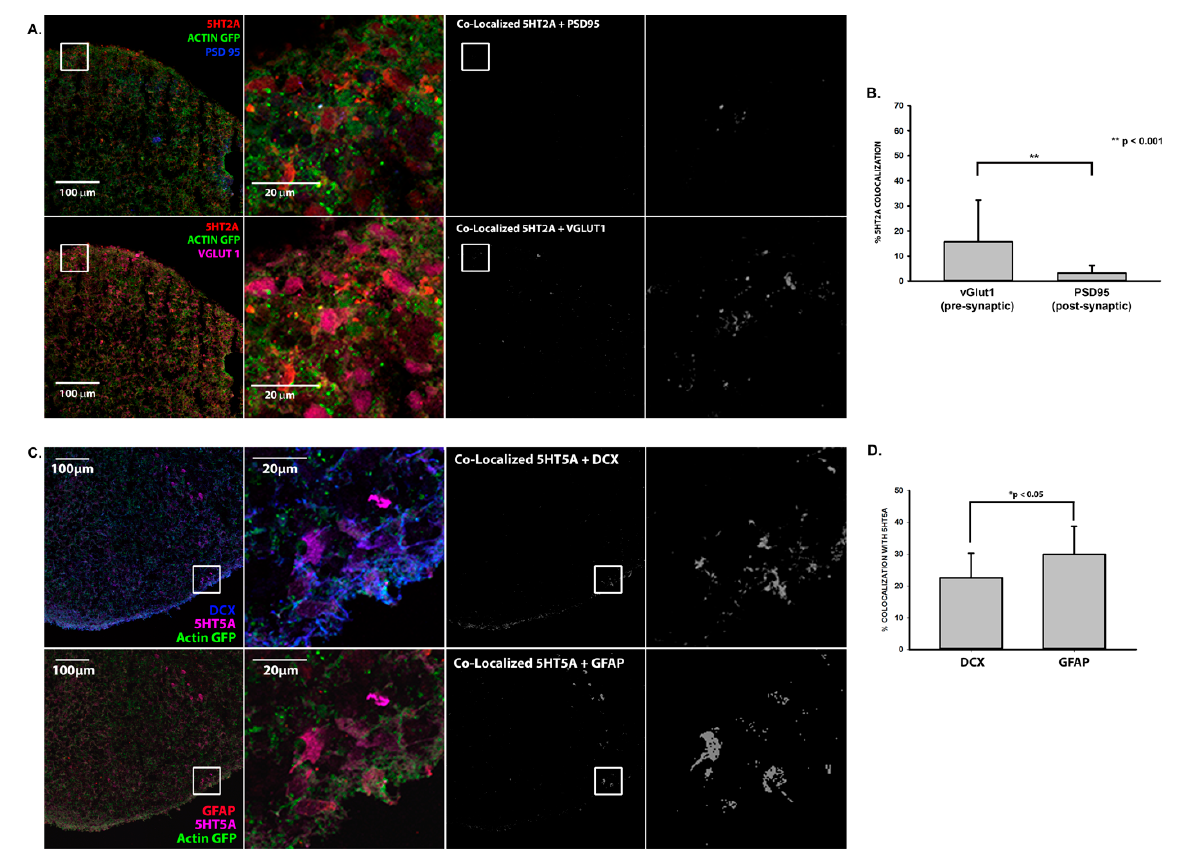
Figure 3. Expression of serotonin receptors in human cortical spheroids. ( A ) 3-month-old untreated cortical spheroids were immunostained for the serotonin receptor, 5-HT2A (red), and excitatory post- (PSD95, blue) and pre- (VGLUT1, magenta) synaptic markers and imaged with confocal microscopy together with endogenous β -actin-GFP. The same cryosection is shown for comparison of 5-HT2A association with PSD95 and VGLUT1. Co-localization between 5-HT2A and the respective synaptic marker is shown in grayscale. The same region of interest is enlarged for the merged and co-localized images. ( B ) Analysis of 5-HT2A colocalization with pre- and post-synaptic markers. ~20% of 5-HT2A co-localizes with pre-synaptic VGLUT1. n = 11 cryosections from 4 independent cortical spheroid cultures. ( C ) 3-month-old untreated cortical spheroids were immunostained for the serotonin receptor, 5-HT5A (magenta), and doublecortin (blue) to identify neurons and GFAP (red) to identify astrocytes and were imaged with confocal microscopy together with endogenous β -actin-GFP. The same cryosection is shown for comparison of 5-HT5A association with doublecortin (DCX) and GFAP. Co-localization between 5-HT5A and either DCX-positive neurons or GFAP-positive astrocytes is shown in grayscale. The same region of interest is enlarged for the merged and co-localized images. ( D ) Analysis of DCX-positive neurons or GFAP-positive astrocytes co-localized with 5-HT5A. Approximately 30% of GFAP co-localizes with 5-HT5A, significantly more than the ~20% of DCX positive neurons. n = 12 cryosections from 4 independent cortical spheroid cultures. Scale bar = 100, 20 μ m.